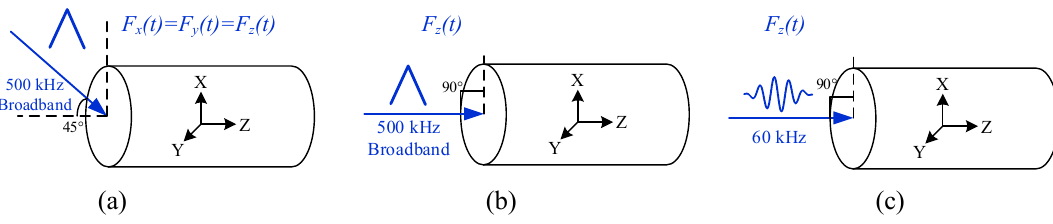
Figure 6. Guided waves in a single wire were excited using three loading methods: ( a ) an oblique triangular pulse with three equal components along the x , y , and z directions, ( b ) a perpendicular triangular pulse along the z -direction, and ( c ) a perpendicular sinusoidal tone burst along the z - direction.